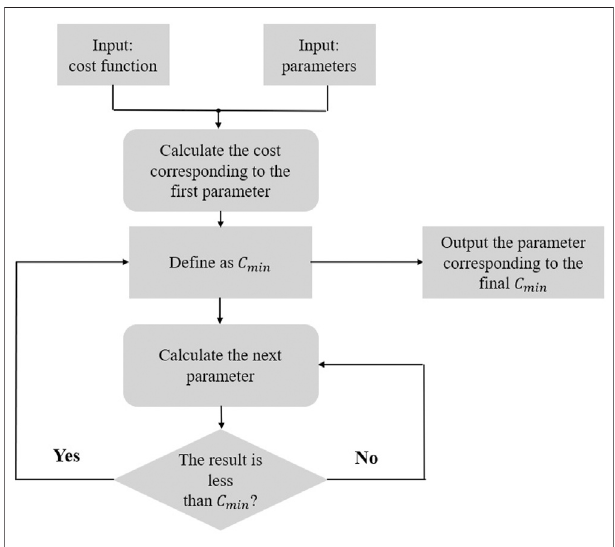
FIGURE 3 | Logic diagram of temperature resetting optimization.